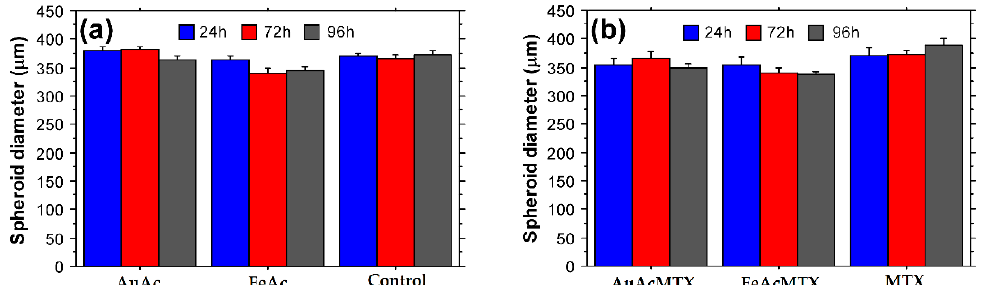
Figure 13. Effects of AuAc, FeAc, AuAcMTX, FeAcMTX, and MTX on HT29 spheroid size. HT29 spheroids were treated with 100 μ g/mL AuAc, FeAc, AuAcMTX, FeAcMTX, or MTX for 96 h and the diameter of multicellular aggregates was measured at different time-points (24, 72, and 96 h). ( a ) Spheroid size following treatment with AuAc or FeAc. Control—spheroids cultured in standard growth medium without addition of NP samples. ( b ) HT29 spheroid dimensions after treatment with AuAcMTX, FeAcMTX, or MTX. All samples were assayed in triplicate.